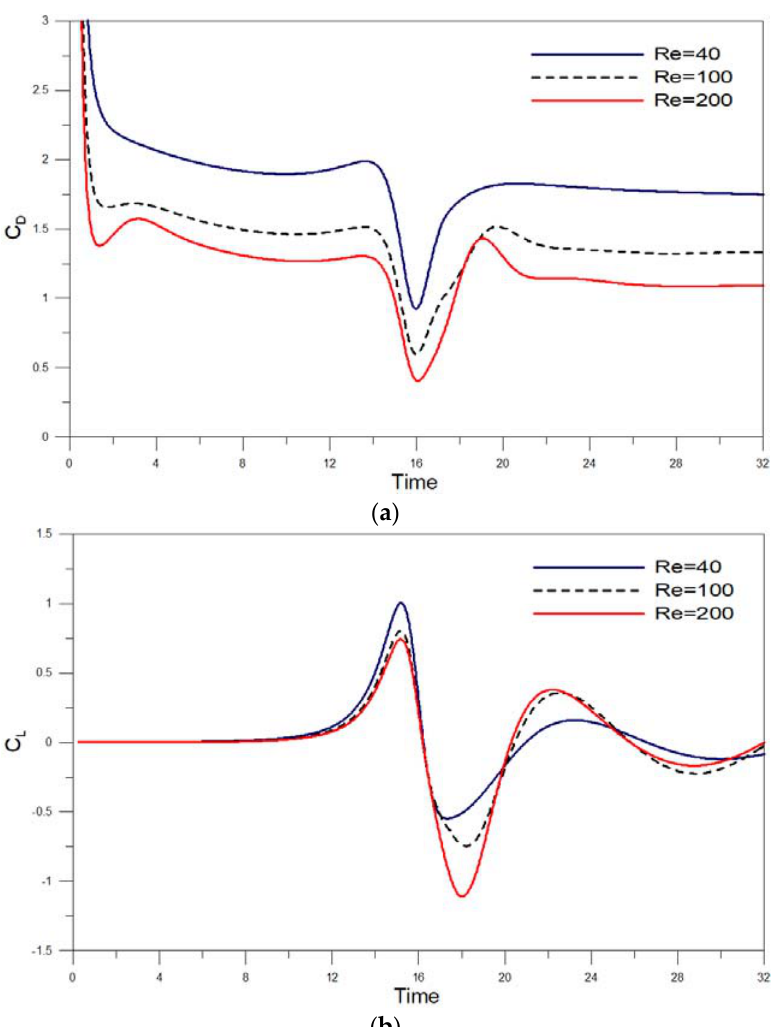
Figure 7. Comparisons of drag and lift coefficients on upper cylinder at various Reynolds numbers: ( a ) drag coefficient and ( b ) lift coefficient.